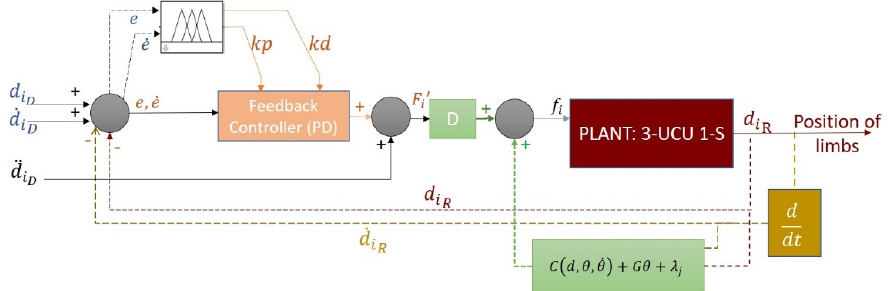
Figure 8. Block diagram of the implementation of the gain channeling fuzzy logic system inside the feedforward plus feedback controller.